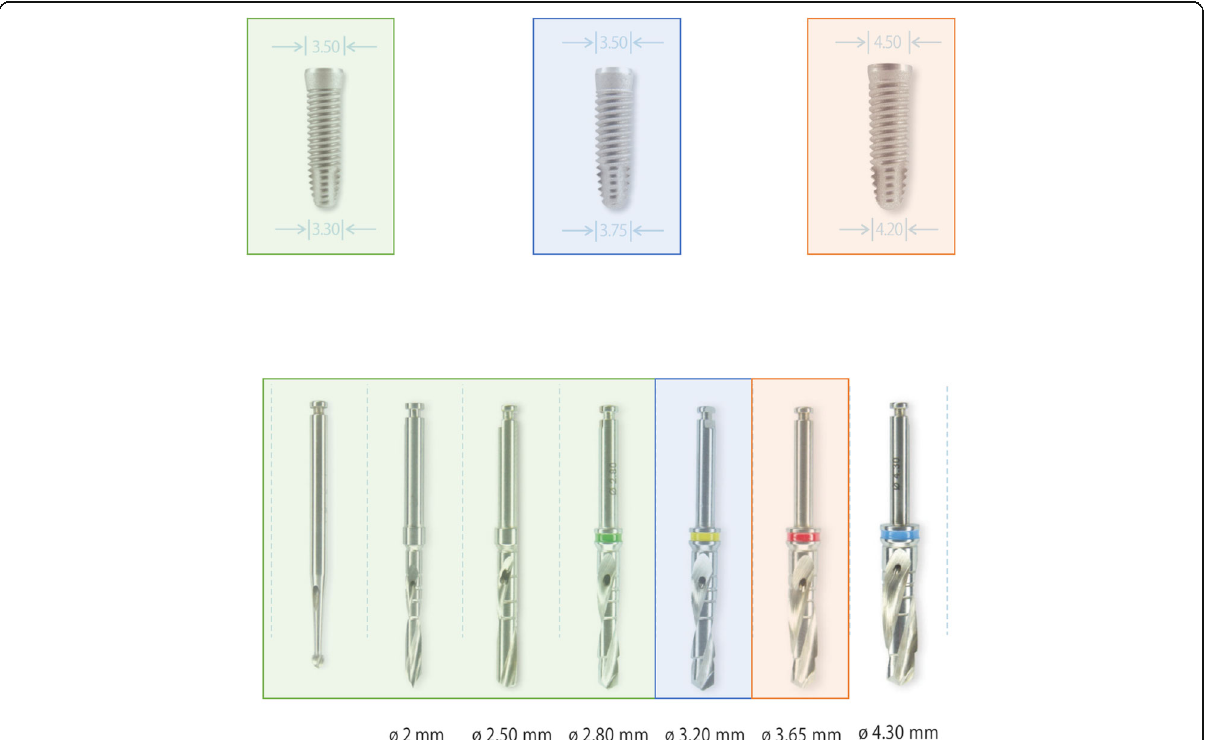
Fig. 1 Standard protocol. This figure shows the implant types and drilling protocol used within this study. Standard protocol was conducted by a final drill of 2.80 mm for 3.3 mm implants, 3.20 mm for 3.75 mm implants, and 3.65 mm for 4.2 mm implants. Permissions for reproducing